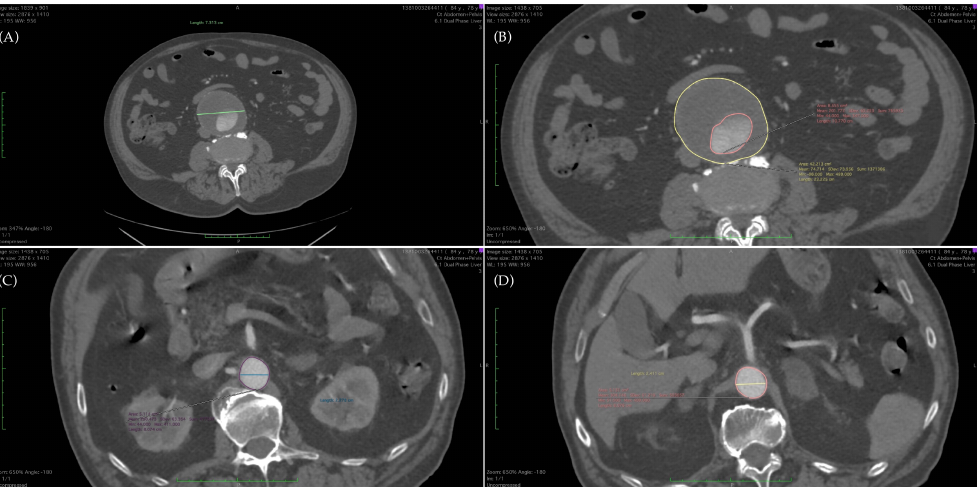
Figure 1. CT angiography: ( A ) maximal diameter of AAA (axial section); ( B ) surface of AAA at maximal diameter (yellow) and surface of lumen (orange); ( C ) diameter and surface of aorta at renal level; and ( D ) diameter and surface of aorta at celiac trunk level.